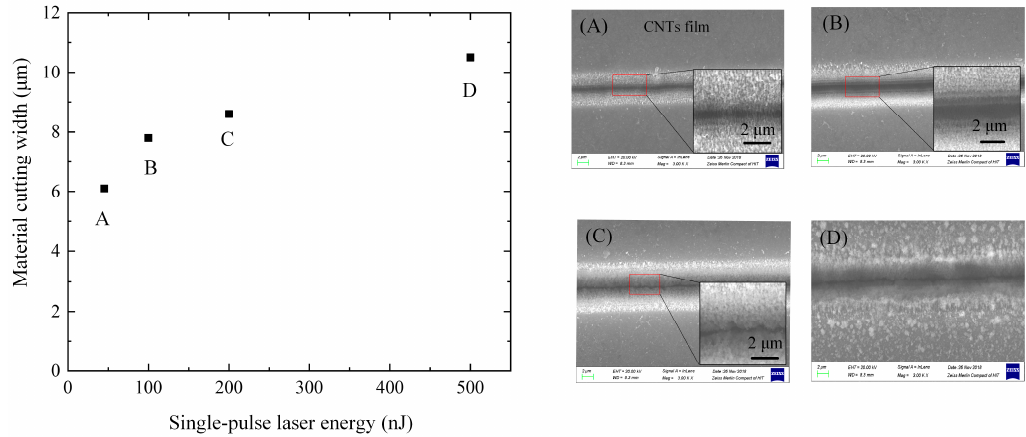
Figure 9. SEM images of CNT film ablation grooves with different single pulse energies (A) E = 45 nJ; (B) E = 100 nJ; (C) E = 200 nJ; (D) E = 500 nJ.